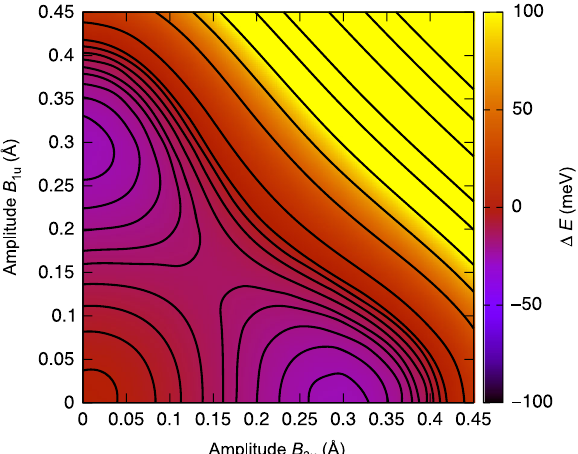
Fig. 2 Energy landscape for BiMO vs ferroelectric distortions. Energy of BiMO as a function of the distortion along the two main unstable (and both polar) modes of the high-symmetry